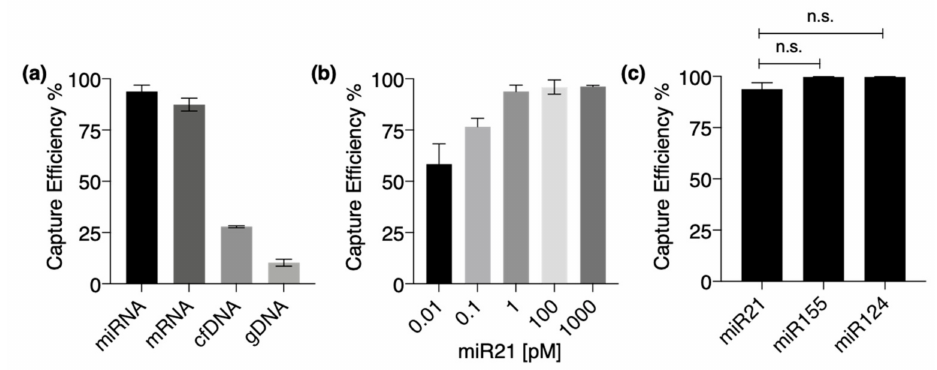
Figure 4. Capture of miRNAs on annealed ZnO/Al 2 O 3 core-shell nanowires. ( a ) Comparison of capture efficiency of the nucleic acids, miRNAs, mRNAs, cfDNAs, and gDNAs. ( b ) Capture efficiency of miR21 on nanowire at presences of 0.01, 1, 10, and 1000 pM. ( c ) Comparison of capture efficiency of miR21, miR155, and miR124. Error bars show standard deviation for a series of measurements (n = 3). n.s. indicates not